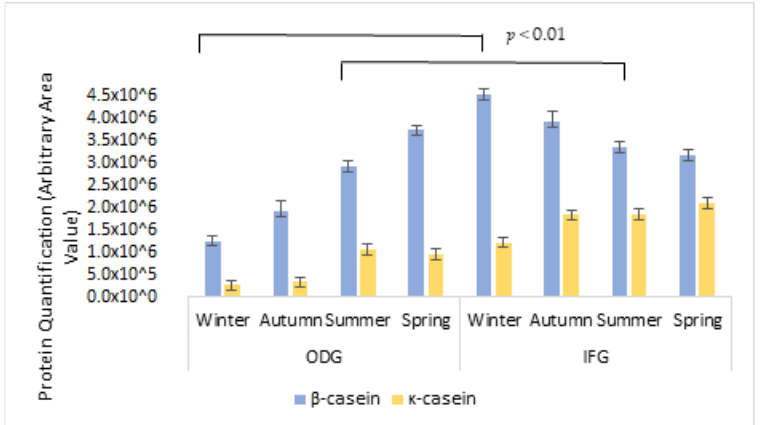
Figure 3. Immunoblotting of cow milk caseins during all seasons between ODG and IFG farming systems. Data are reported as area percentage ± S.D. of the total retinol concentration in each sample. p < 0.01. ODG: Outdoor grazing, IFG: intensive feeding.